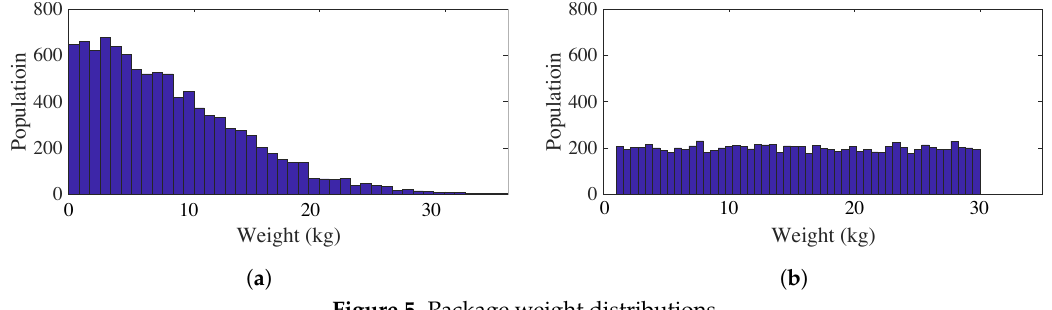
Figure 5. Package weight